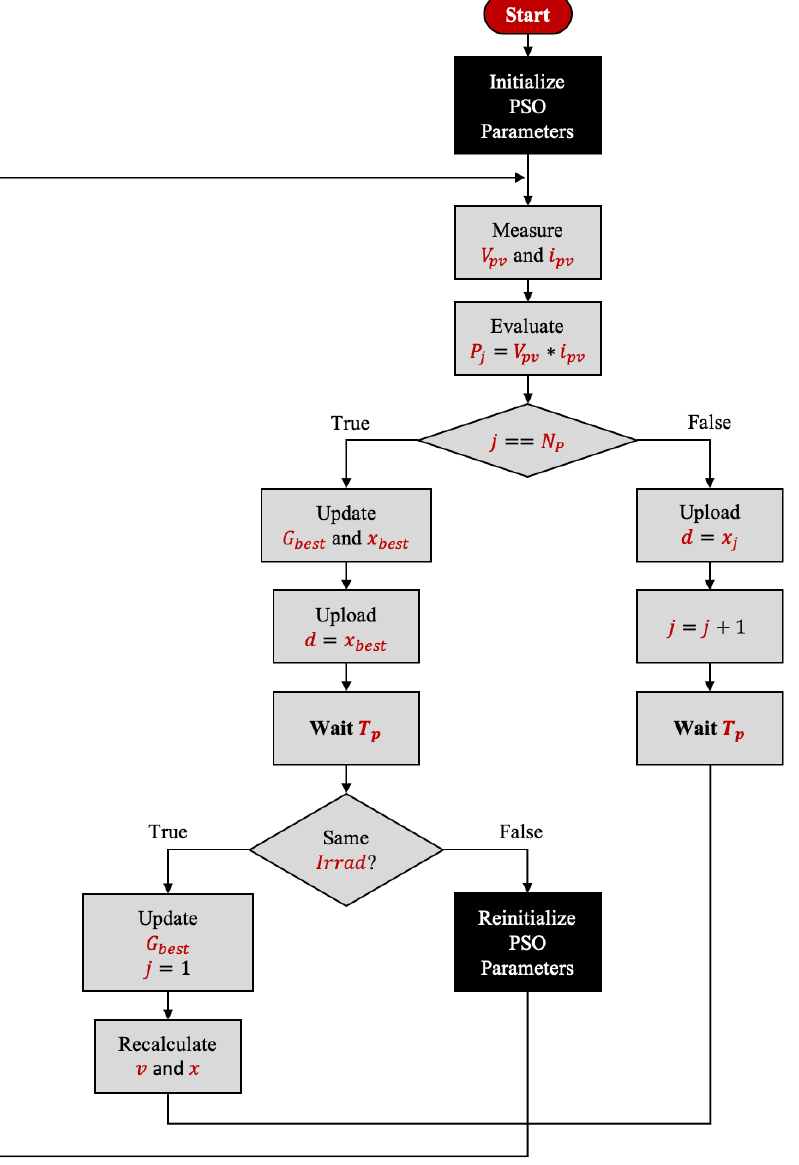
Figure 6. Flow chart of the Particle Swarm Optimization (PSO) MPPT